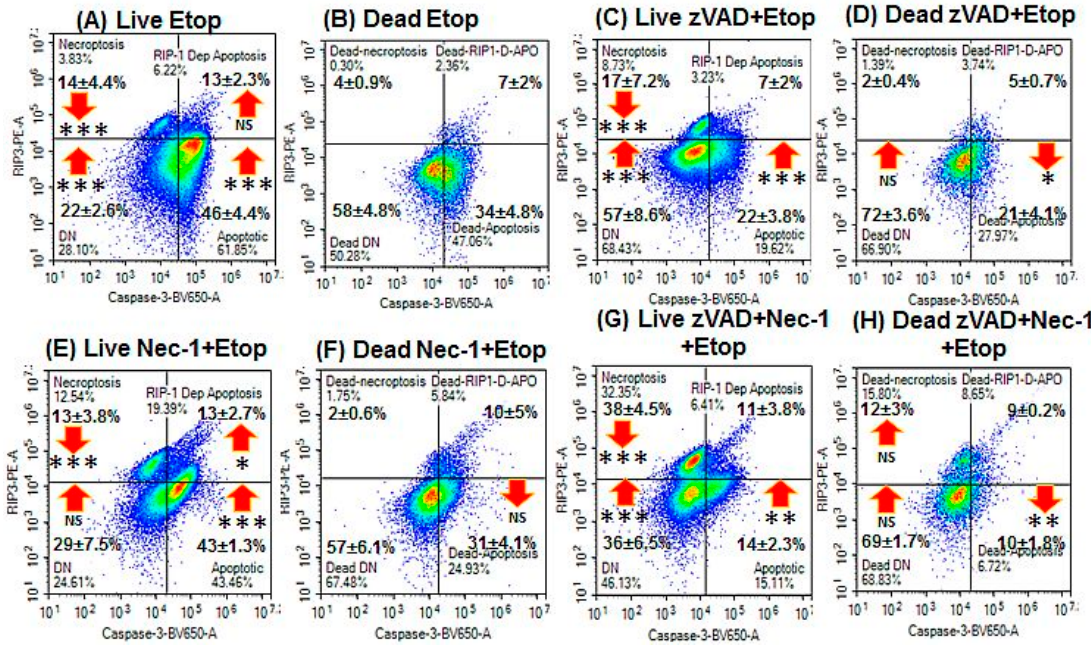
Figure 4. RIP3 and caspase-3 activation analysis of apoptosis. Gating on live and dead cells from a Zombie NIR vs. caspase-3-BV650 plot followed by analysis on a RIP3-PE vs. caspase-3-BV650 plot with resting phenotype indicated by RIP3 +ve /caspase-3 –ve , apoptosis by RIP3 –ve /caspase-3 +ve , RIP1-dependent apoptosis by RIP3 +ve /caspase-3 +ve and double negative by RIP3 –ve /caspase-3 –ve . ( A,B ) Treated with 1 μ M Etop for 24 h; ( C , D ), pre-treated with 20 μ M zVAD for 2 h, then treated with 1 μ M Etop; ( E , F ) pre-treated with 60 μ M Nec-1 for 2 h, then treated with 1 μ M Etop; and ( G , H ) pre-treated with 20 μ M zVAD and 60 μ M Nec-1 for 2 h, then treated with 1 μ M Etop. N = 3, % Mean ± % SEM, Student’s t –test: NS (not significant), * p < 0.05, ** p < 0.01**, *** p < 0.001; arrows indicate change compared with untreated cells.